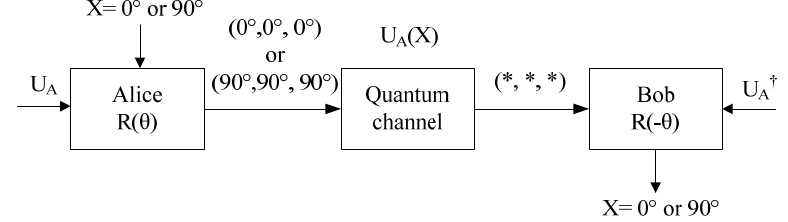
Figure 4. Quantum Communication using the multiphoton approach.